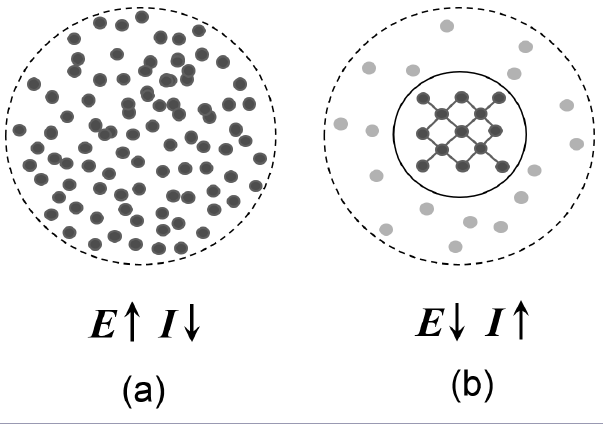
Fig. 1 . Illustration of the concept of information as the complement of entropy: (a) a highly disordered system with high entropy and low information and (b) an ordered system with lower entropy and higher